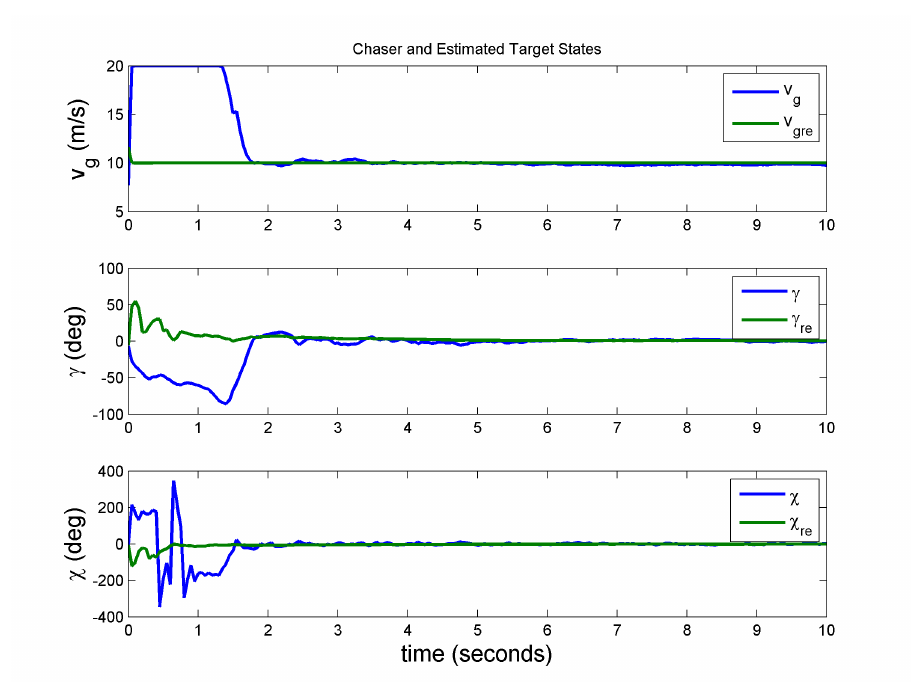
Figure 4. Position tracking (Case 1A).